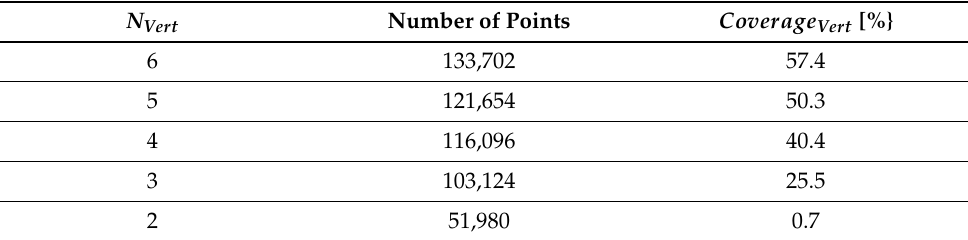
Table 4. Comparison between the variation of Num _ WaY and its impact on the amount of points of 3D